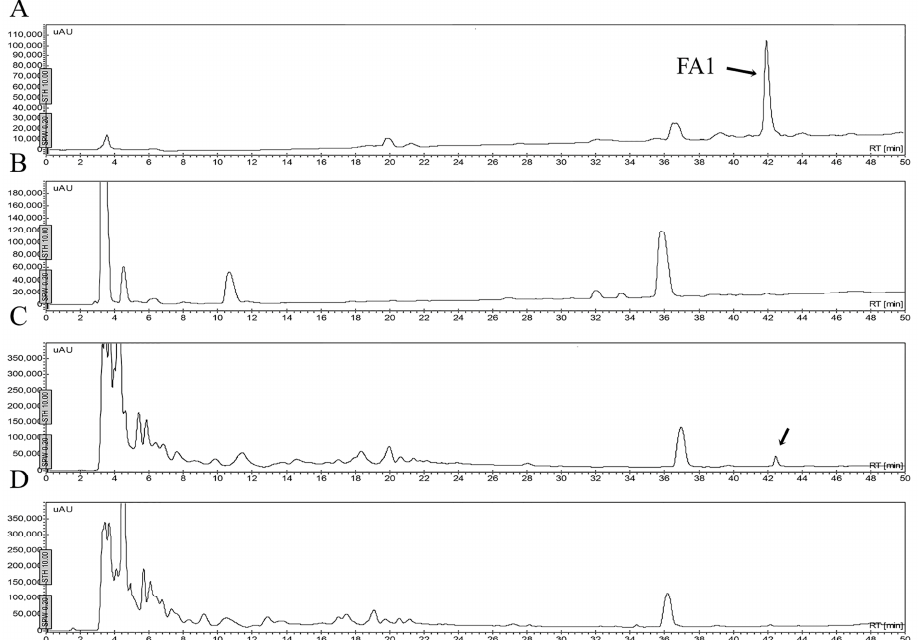
Figure 10. Stability of FA1 in human blood plasma and bacterial supernatants. The peptide was either diluted in human blood or bacterial supernatants, incubated at 37 °C for 12 h and then extracted. ( A ) FA1 was separated by HPLC (control); ( B ) FA1 was diluted with blood, incubated for 12 h at 37 °C, extracted and separated by HPLC; ( C ) FA1 was diluted with Staphylococcus aureus supernatant, incubated for 12 h at 37 °C, extracted and separated by HPLC; and ( D ) FA1 was diluted with Pseudomonas aeruginosa supernatant, incubated for 12 h at 37 °C, extracted and separated by HPLC. The arrow shows the presence of FA1.